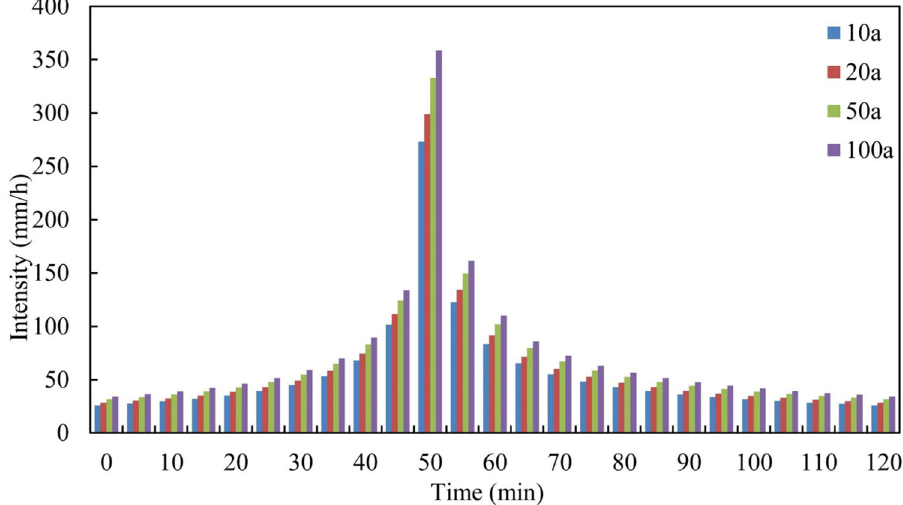
Fig. 6 Hydrographs of the four rainfall return periods (10a, 20a, 50a, and